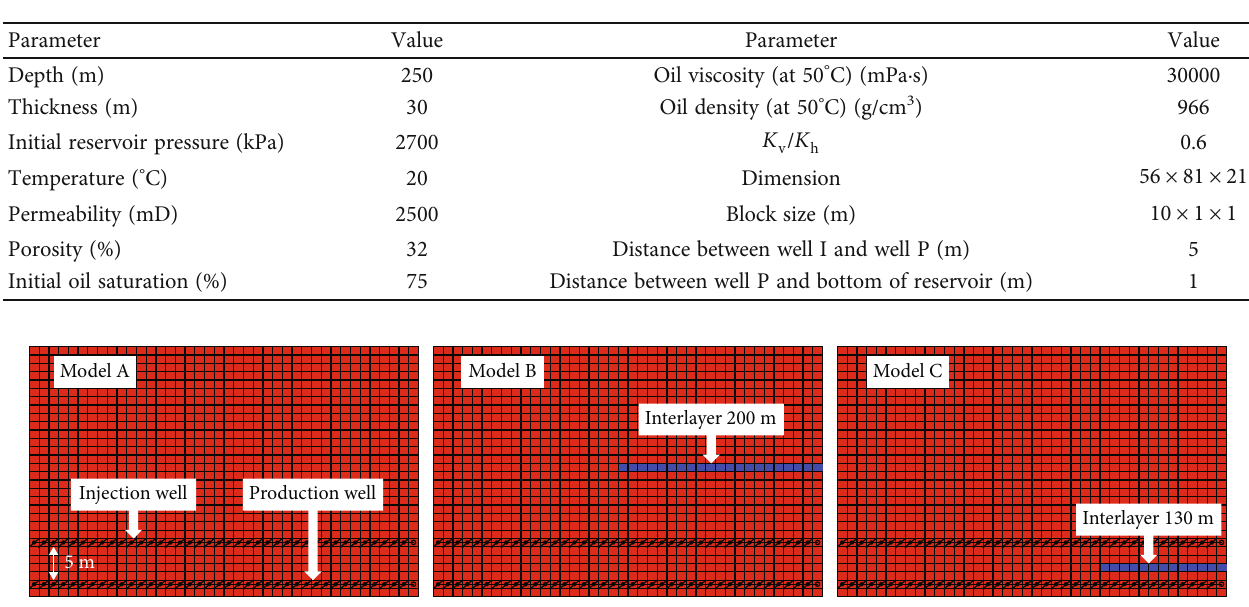
Table 2: Parameters of the simulation model.